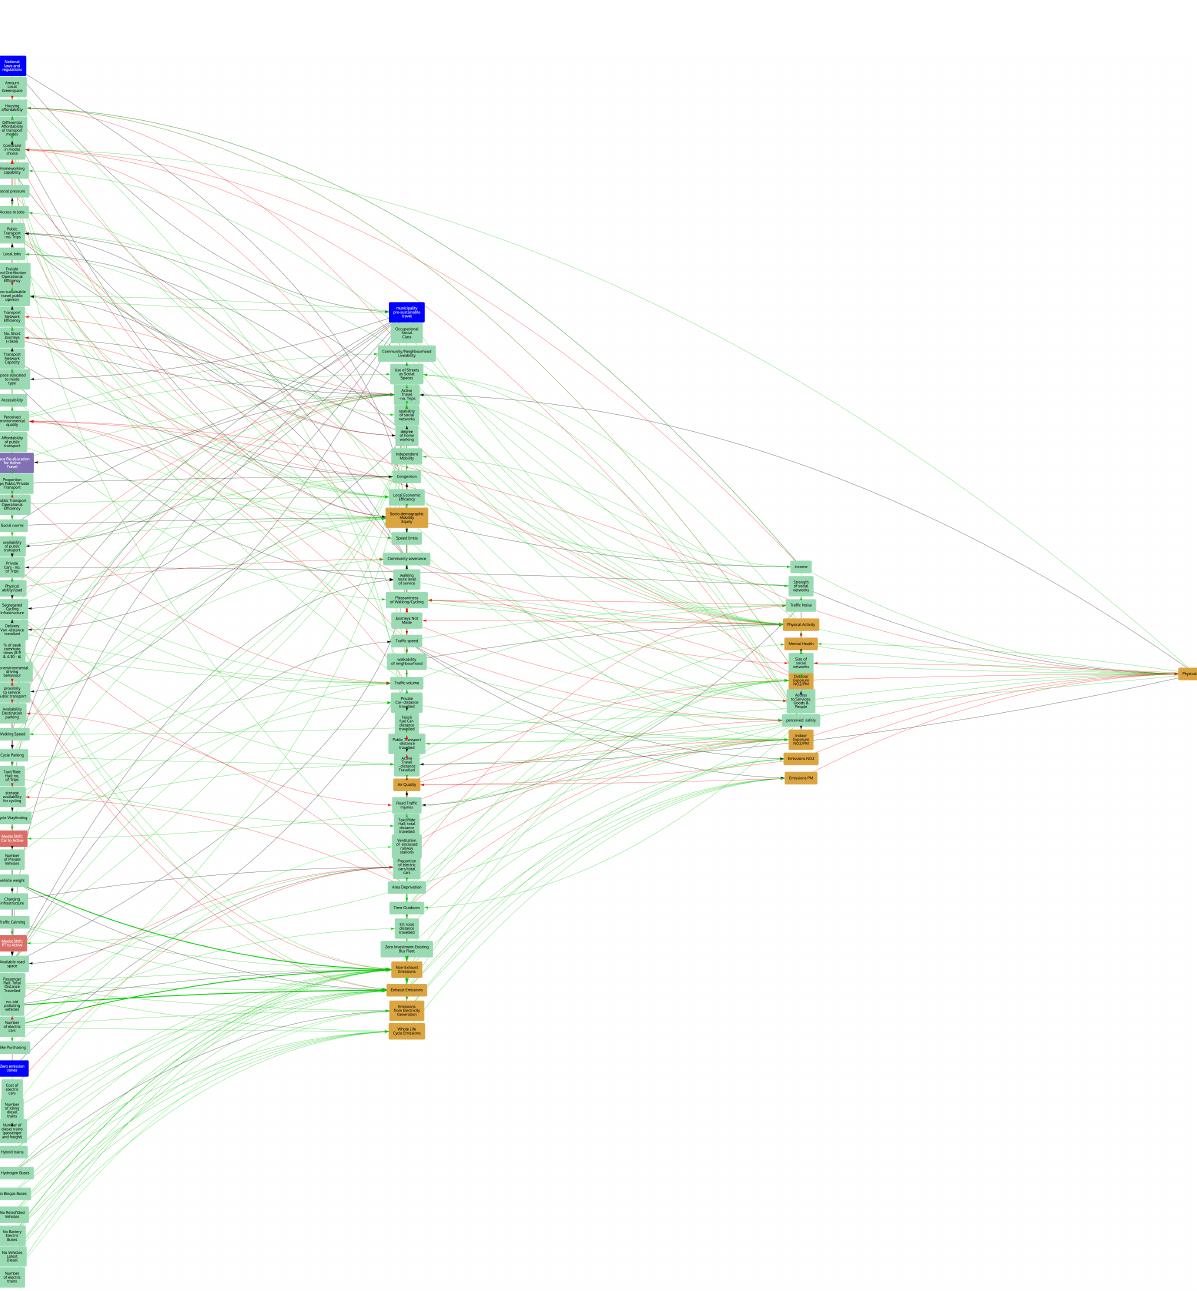
Figure 6. Physical health: upstream 3